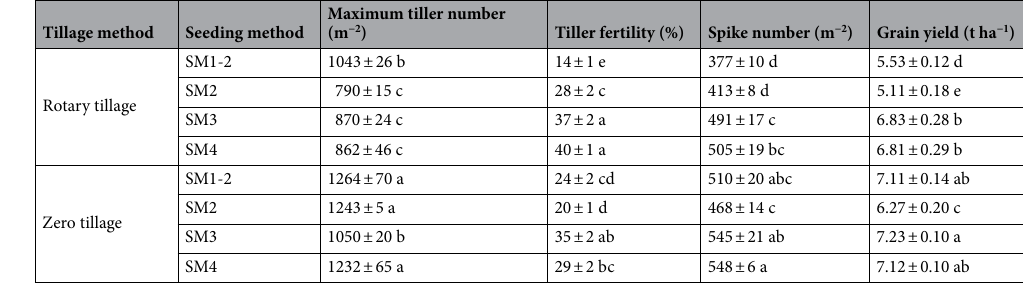
Table 4. Effects of tillage and seeding method combinations on wheat (a) maximum tiller number, (b) tiller fertility, (c) spike number, and (d) grain yield in 2018. Data are presented as means ± standard errors. Different letters indicate significant differences between treatments at the 0.05 probability level. SM1-2 small-size drill seeder, SM2 small-size strip seeder, SM3 medium-size strip seeder, SM4 medium-size drill seeder.